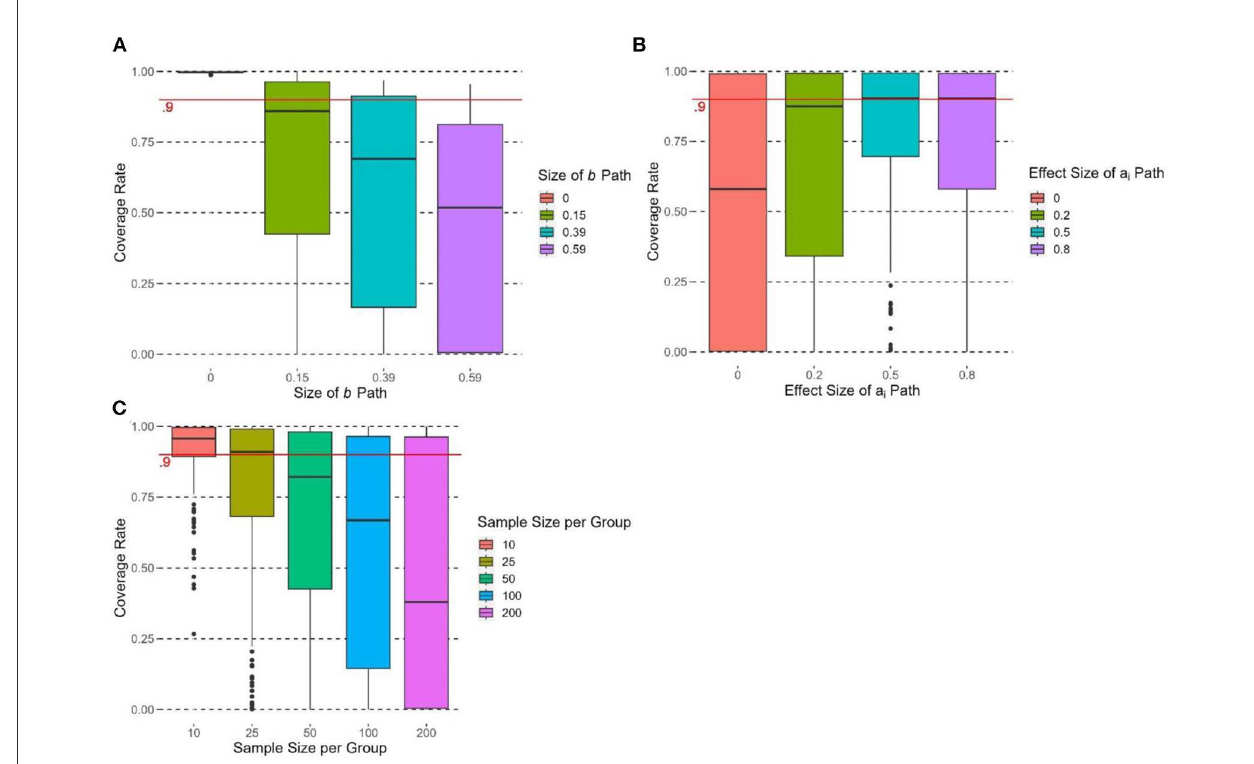
FIGURE6 Boxplots of coverage rate of ˜ υ OPE grouped by (A) size of b path, (B) effect size of a i path, and (C) sample size per group. The cutoff of satisfactory coverage rate (coverage rate > 0.9) is indicated by the solid horizontal line.